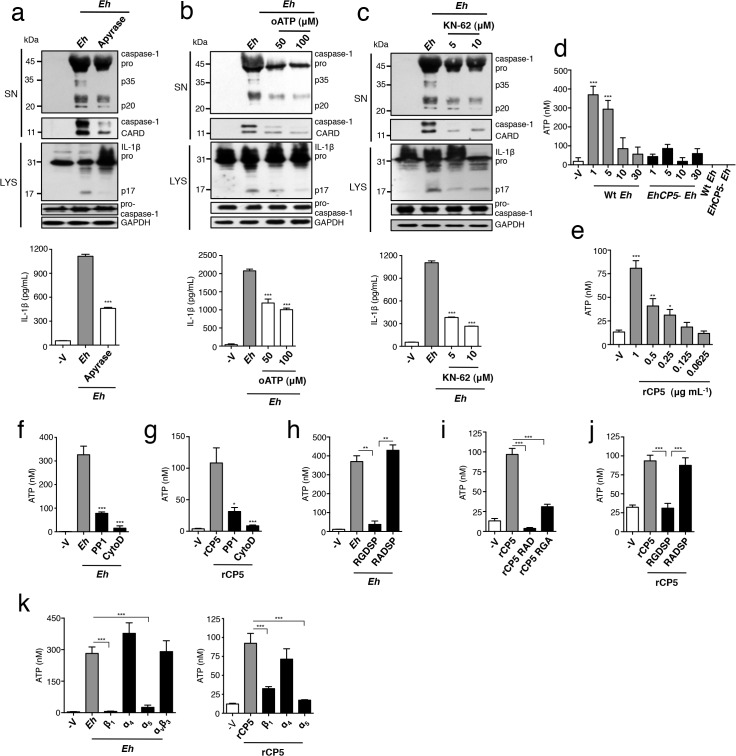
ATP release via α5β1 integrin is required for E. histolytica (Eh) to activate the NLRP3 inflammasome.(a, b, c) Immunoblot analysis of active caspase-1 and IL-1β cleavage products and IL-1β enzyme-linked immunosorbent assay of PMA-differentiated THP-1 macrophages stimulated for 30 min with Wt Eh with the addition of apyrase (30 U mL-1) (a), or P2X7R inhibitors oATP (50–100 μM) (b), or KN-62 (5–10 μM) (c). (d-k) ATP release from PMA-differentiated THP-1 macrophages stimulated for 1 min with or the indicated time with a 1:30 ratio of Wt Eh (d), EhCP5- Eh (d), or rCP5 (e), rCP5 RAD (i), rCP5 RGA (1 μg mL-1 or indicated concentration) (i) without inhibitors or with PP1 control (10 μM) (f, g), or cytochalasin D (10 μM) (f, g), or RGDSP peptide or RADSP control (h, j) (25 μM), or function blocking antibodies to β1, α4, and α5 integrin, αvβ3 integrin (10 μg mL-1) (k) added to cultures 10 min before stimulation or 45 min before stimulation for cytochalasin D. Data are representative of two (d, h-k) or three (a-c, e-g) separate experiments (error bars SEM). ***P < 0.005, *P < 0.05. oATP, oxidized adenosine triphosphate.